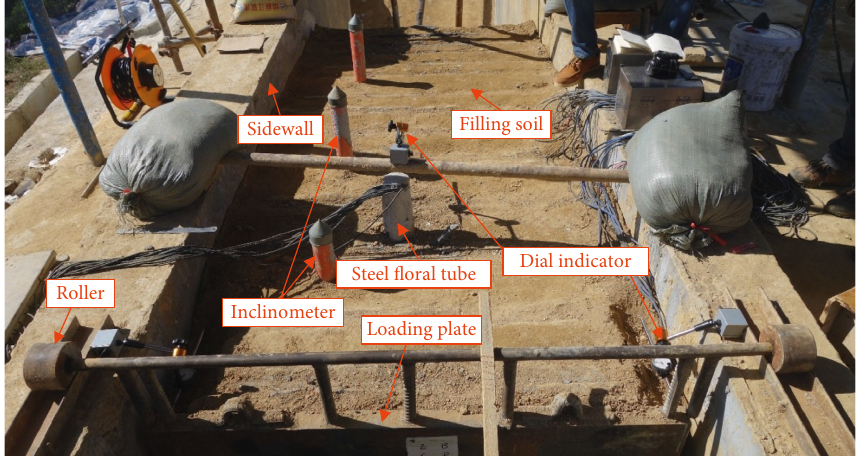
Figure 3: Field test figure of the model